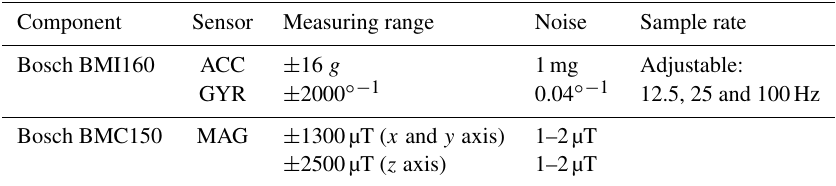
Table 1. Technical specifications of the Smartstone probe v2.0 as provided by Bosch Sensortec GmbH (2014, 2015) and manufacturer information from Smart Solutions Technology